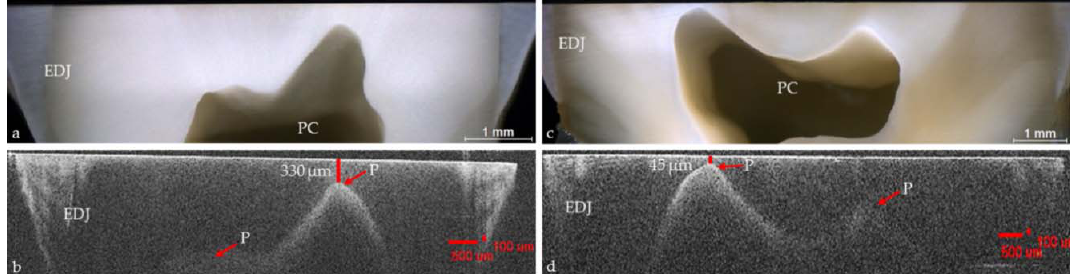
Figure 15. Extracted human molars trimmed and cross ‐ sectioned longitudinally through pulp chamber (PC). Imaging of the pulp borders by ( a , c ) light microscopy, and ( b , d ) SD ‐ OCT, the pulp horns and pulp chamber roof (P) can be clearly visualized in the OCT images. EDJ: enamel ‐ dentin junction.